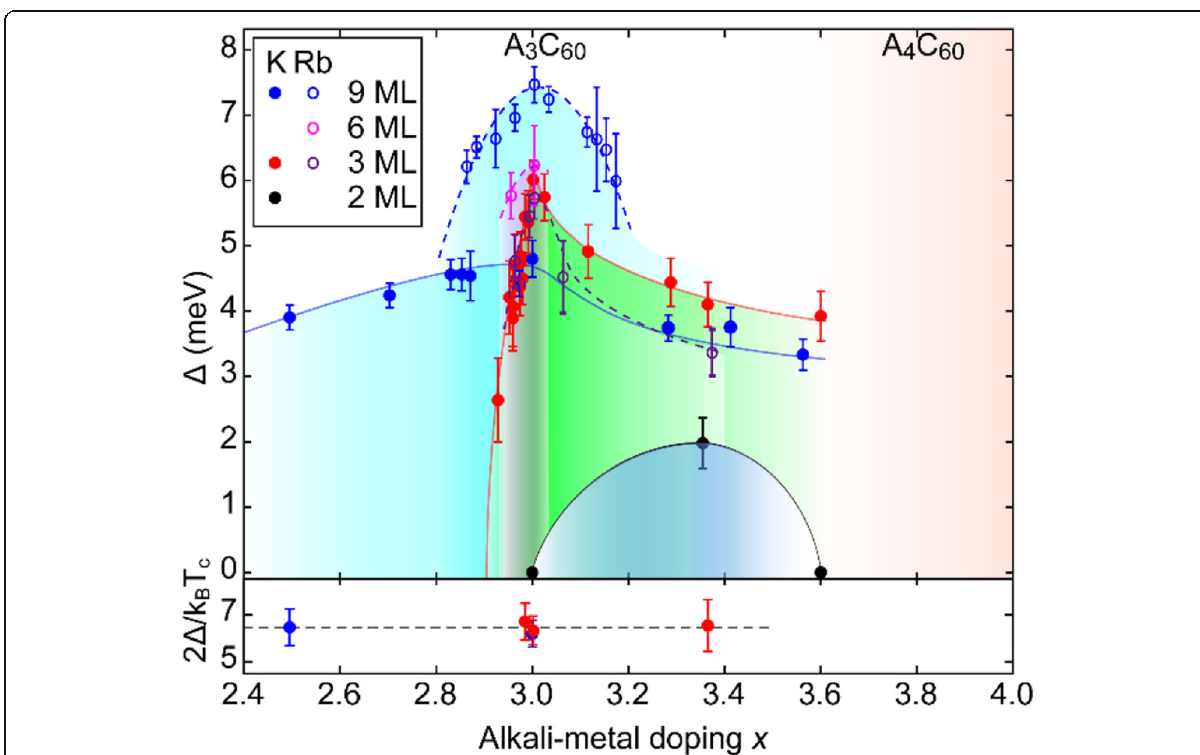
Fig. 18 Electronic phase diagram showing the evolution of Δ , and reduced gap 2 Δ / k B T c of A 3 C 60 films as a function of x. Taken from ref.